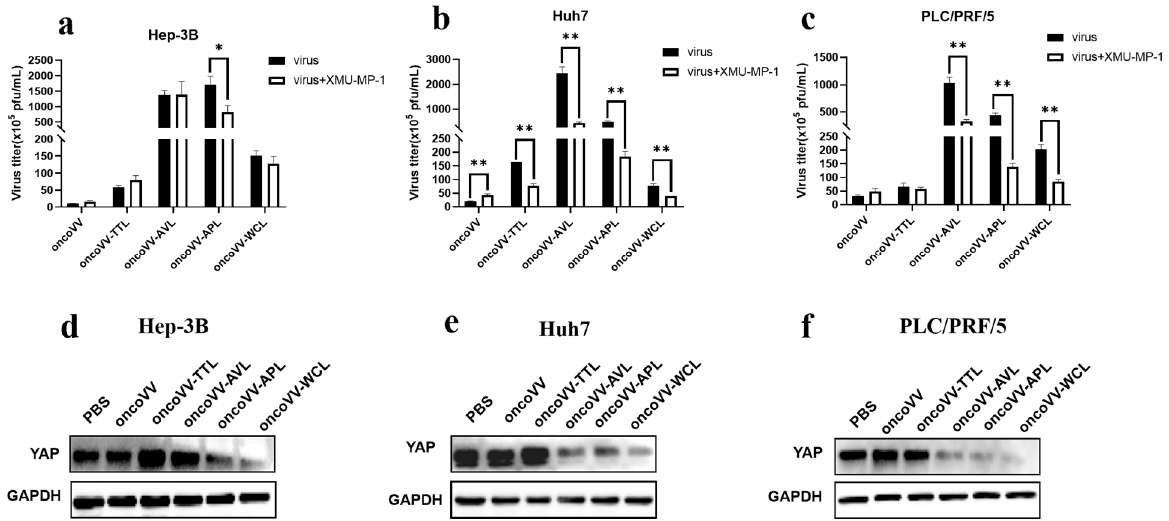
Figure 7. Relationships between Hippo/YAP pathway and virus replication in HCC. ( a – c ) Virus titers in the presence of XMU-MP-1 (* p < 0.05, ** p < 0.01). Hep-3B, Huh7, and PLC/PRF/5 cells were maintained for 12 h, treated with XMU-MP-1 (2 μ mol/L), and infected with 5 MOI of recombinant viruses after 1 h. The samples were collected at 36 h postinfection. ( d – f ) The expression of YAP in Hep-3B ( d ), Huh7 ( e ), and PLC/PRF/5 ( f ) cells. The YAP protein extracts after 36 h treatment were subjected to WB analysis. PBS and oncoVV served as the controls, and GAPDH was a loading con-